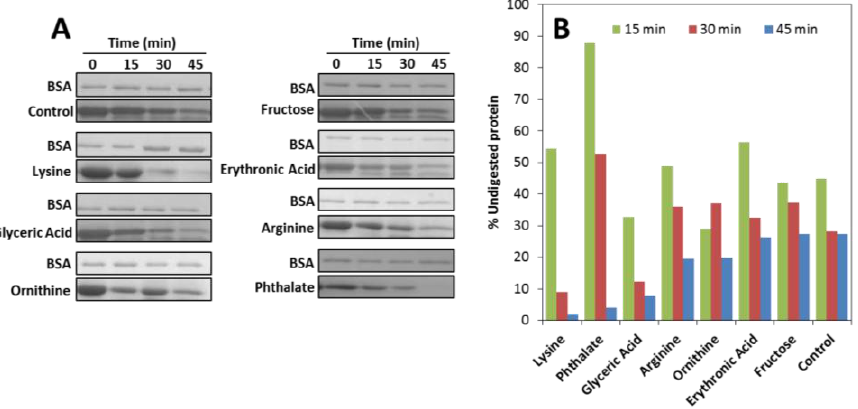
Figure 2. Metabolites increase apoSOD1 proteolytic susceptibility. ( A ) SDS-PAGE analysis of a time course trypsin digestion experiment (50 μM apoSOD1 and 200 μM of metabolites); ( B ) Percentage of digested apoSOD1 in the presence of the different metabolites after 15, 30 and 45 min of incubation with trypsin. See experimental